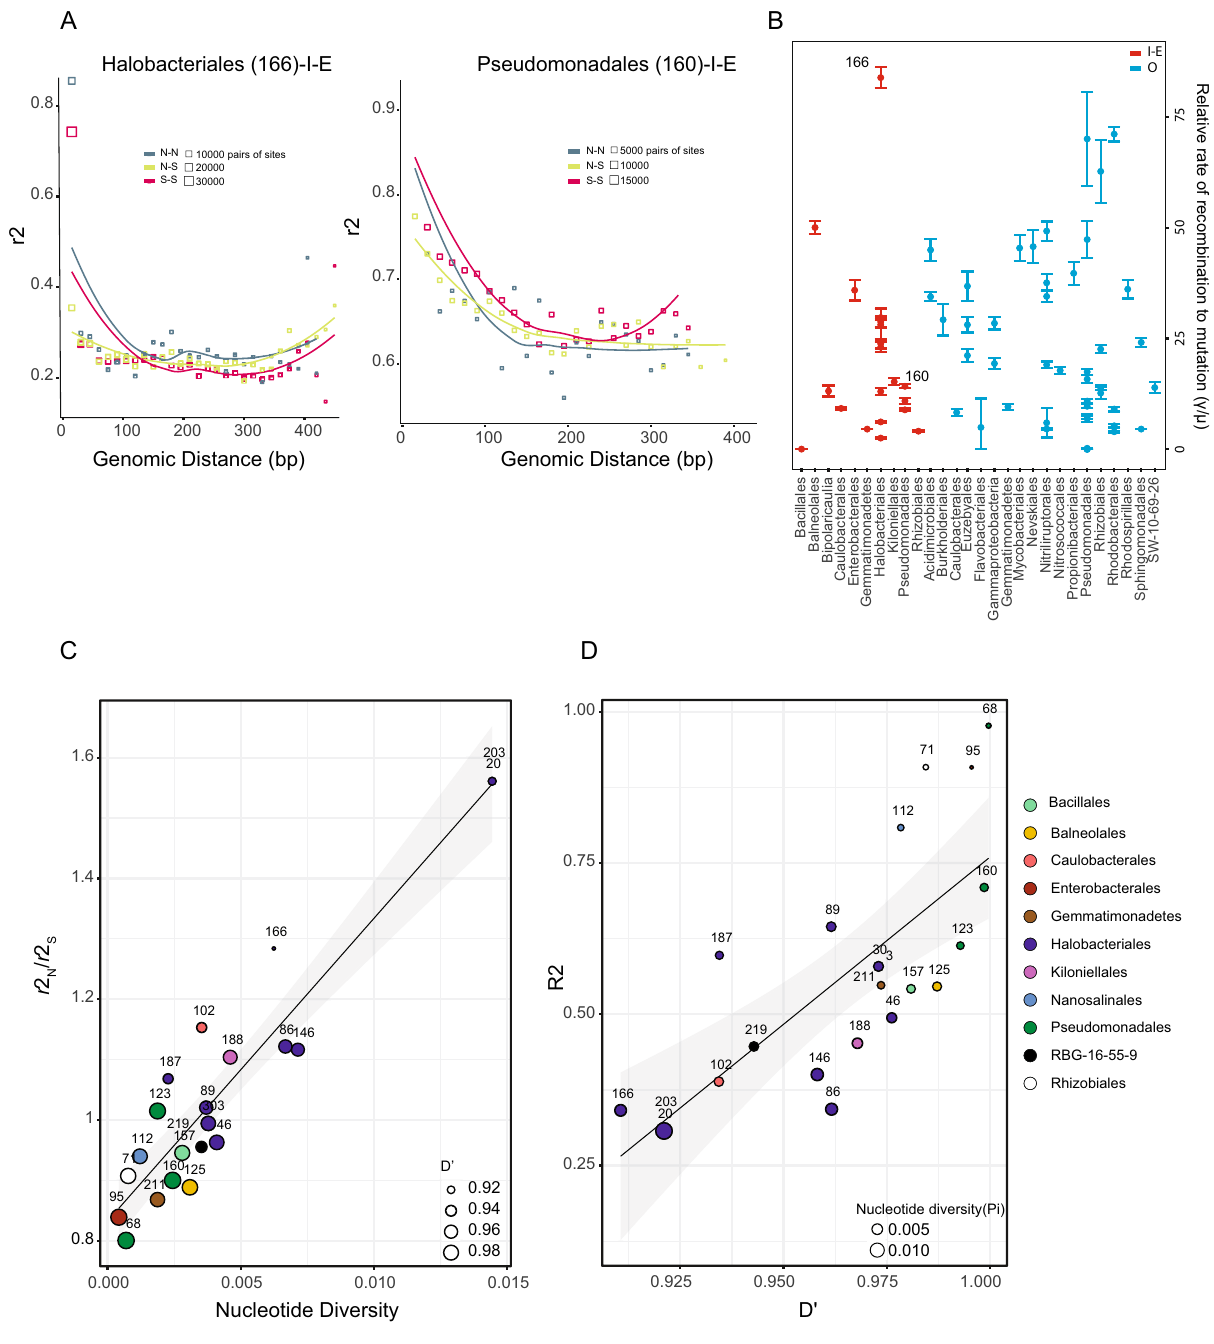
Figure 7. Varying rate of linkage disequilibrium within populations. ( A ) Example of linkage decay represented with (r2) for a pair of loci within population for the highest nucleotide diversity for Halobacteriales (166) (left panel), and for the lowest nucleotide diversity for Pseudomonadales (160) (right panel) on the inner sabkha. Squares are average of pairs of biallelic sites at that distance that went into the mean calculation. The predicted mutational functions of the paired SNPs are binned by nonsynonymous (N) and synonymous (S). ( B ) Relative rate of recombination to mutation calculated with mcorr package for different population of inner and outer sabkha. Halobacteriales (166) and Pseudomonadales (160) are labeled on the plot on the inner sabkha. Error bars are 95% confidence interval across 1000 bootstraps. The relative decay of linkage disequilibrium for different populations from inner and outer is summarized in Supplementary Fig. 13. ( C ) The correlation between mean linkages of nonsynonymous-nonsynonymous over synonymous-synonymous (r2N/r2S) and mean nucleotide diversity for pairs of mutations across different species for inner sabkha. D ′ is represented by point with different sizes, which is represented by the mean. A linear regression is plotted (Supplementary Fig. 14). ( D ) The correlation between mean r2 to mean D ′ across the different population on inner sabkha. A linear regression plot is shown (Supplementary Fig. 15). Correlation of r2N/r2S and nucleotide diversity as well as r2 and D ′ are shown in Supplementary Figs. 14,